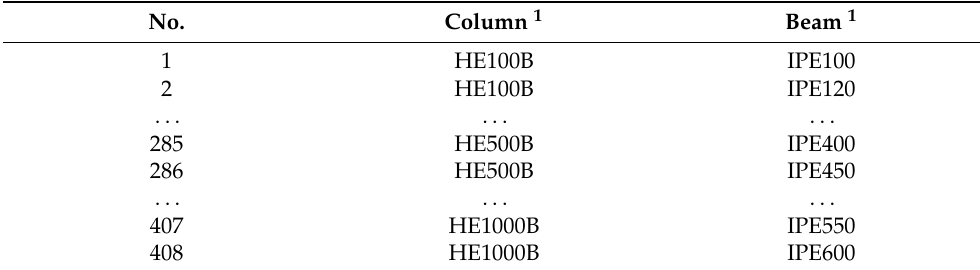
Figure 8. Available connection configurations for one pair of beam – column: ( a ) Neither continuity plates nor ribs; ( b ) Only continuity plates; ( c ) Only ribs; ( d ) Both stiffeners and ribs. Table 1. Pairs of beam–column.